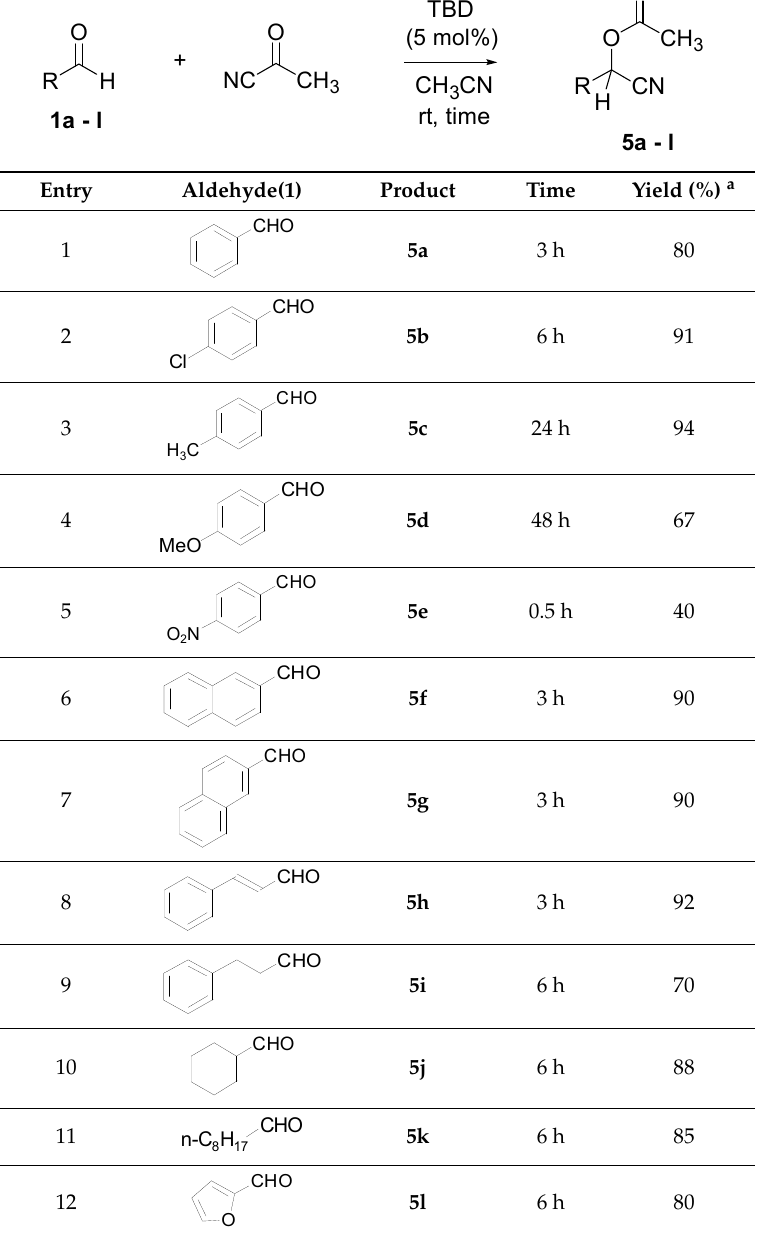
Table 3. TBD catalyzed cyanation of aldehydes with acetyl cyanide .